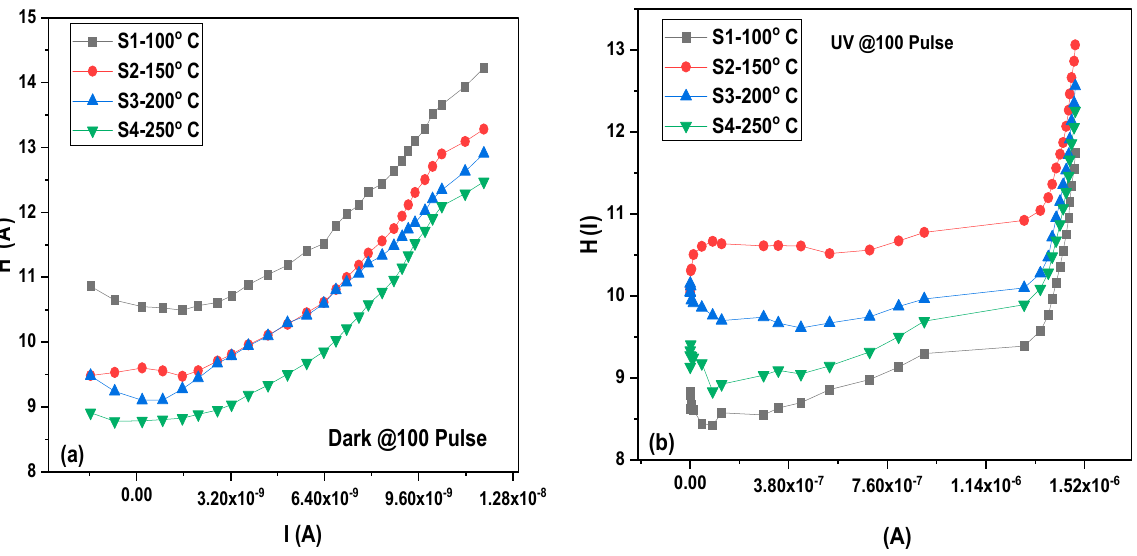
Figure 10. H(I) vs. I of MoO 3 /Si heterostructure photodetector at different irradiance levels for dark (a) and UV irradiance (b)